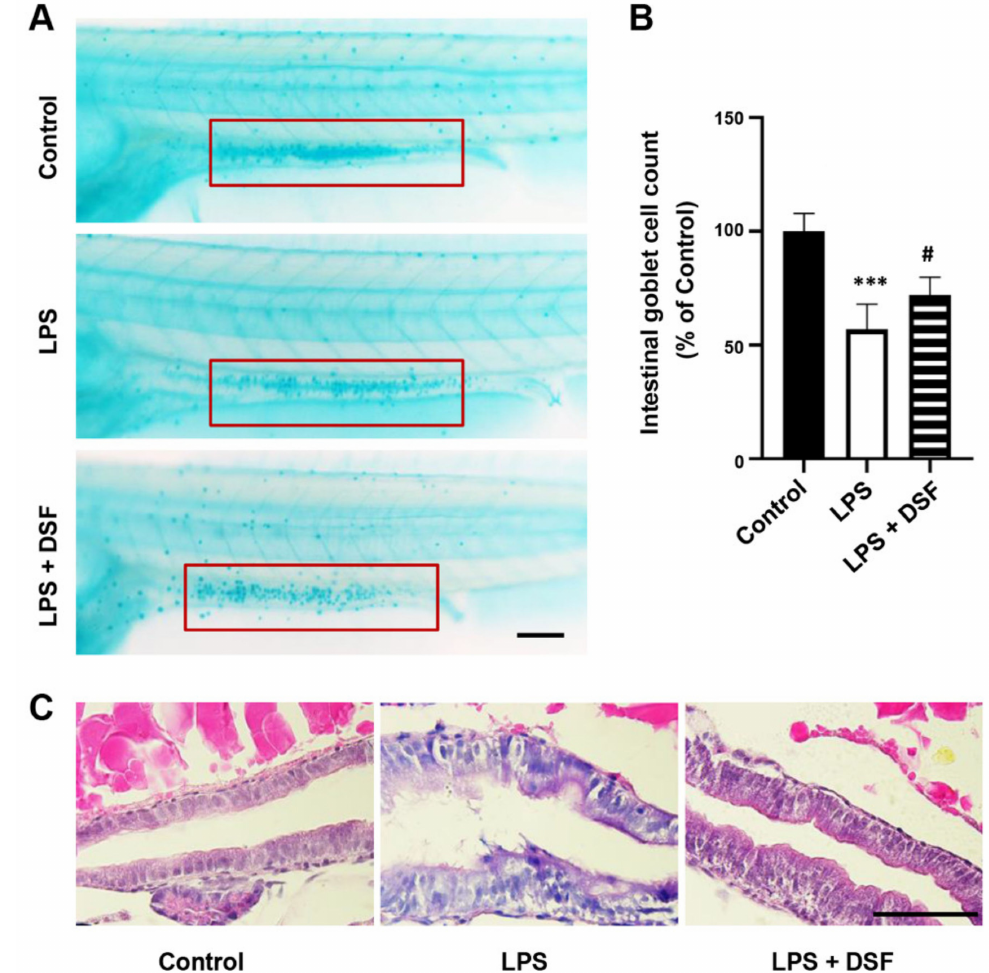
Figure 2. DSF ameliorated intestinal damage of zebrafish embryos after LPS-induced inflamma- tion. ( A ) The goblet cells in zebrafish intestinal mucosa were stained with alcian blue (red boxes). ( B ) The intestinal goblet cells (red boxes) in A were enumerated. ( C ) The histopathological changes in the zebrafish intestine were detected with H&E staining. Data are represented as mean ± S.D. *** p < 0.001 vs. control group; # p < 0.05 vs. LPS group. Scale bar, 100 µ